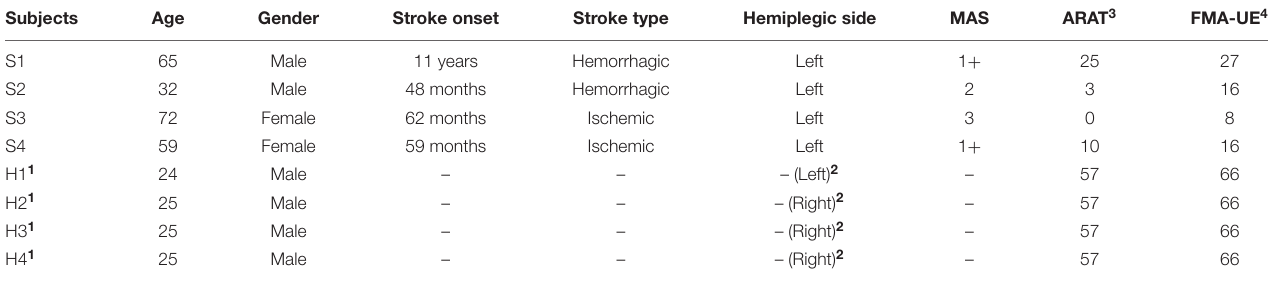
TABLE 1 | Demographic information of the recruited